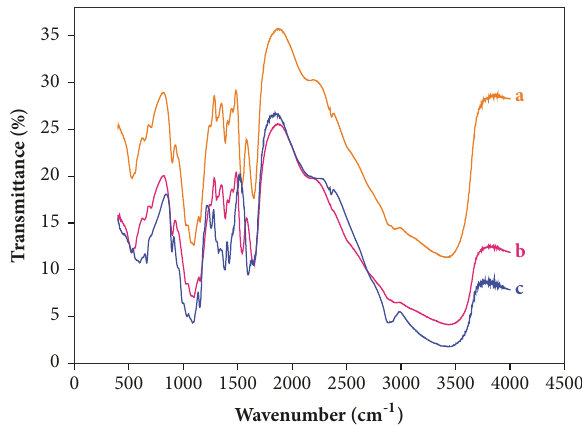
Figure 10: The polarization curves of the CNTs/CA/CC cathodic electrode. (a) Saturated argon. (b) Air. (c) Saturated oxygen.